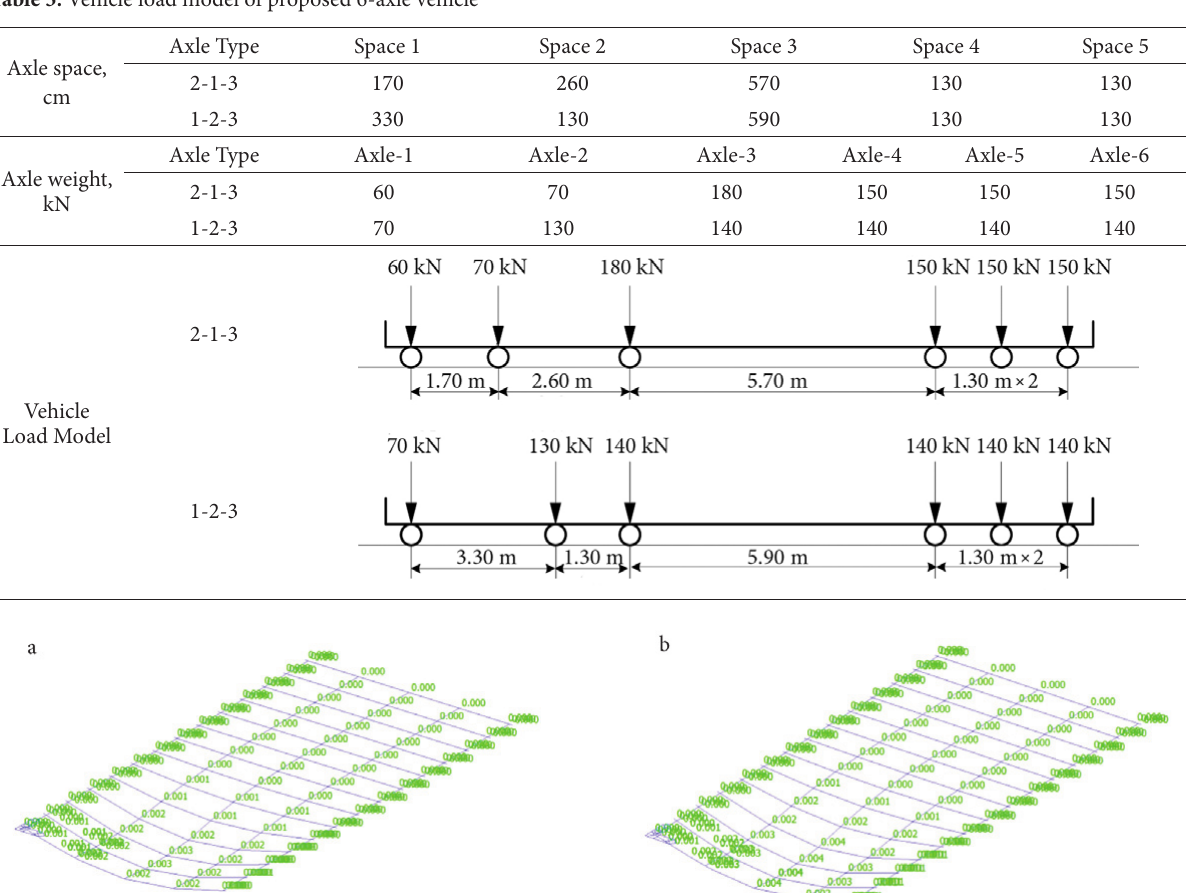
Fig. 15. Comparison of deflection between code model and measured model: a – standard load model; b – measured load